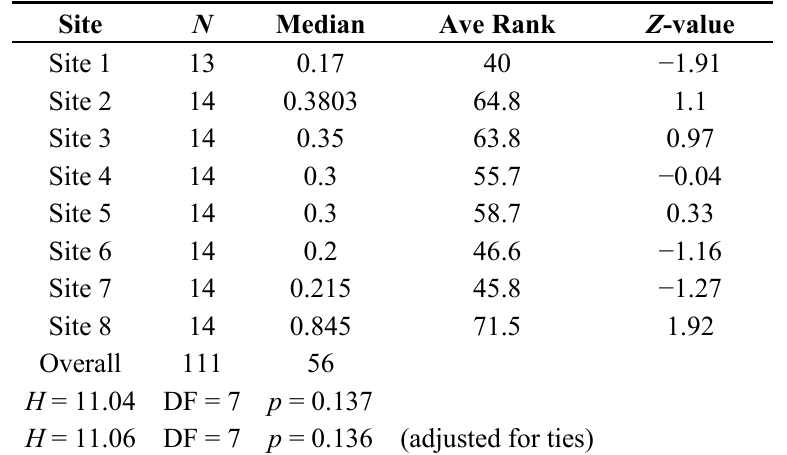
Table 1. The Kruskal-Wallis Test for different sampling sites for